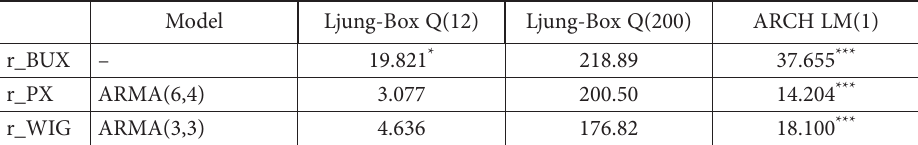
Table 2. Conditional mean equations and residual diagnostics (source: own calculations in